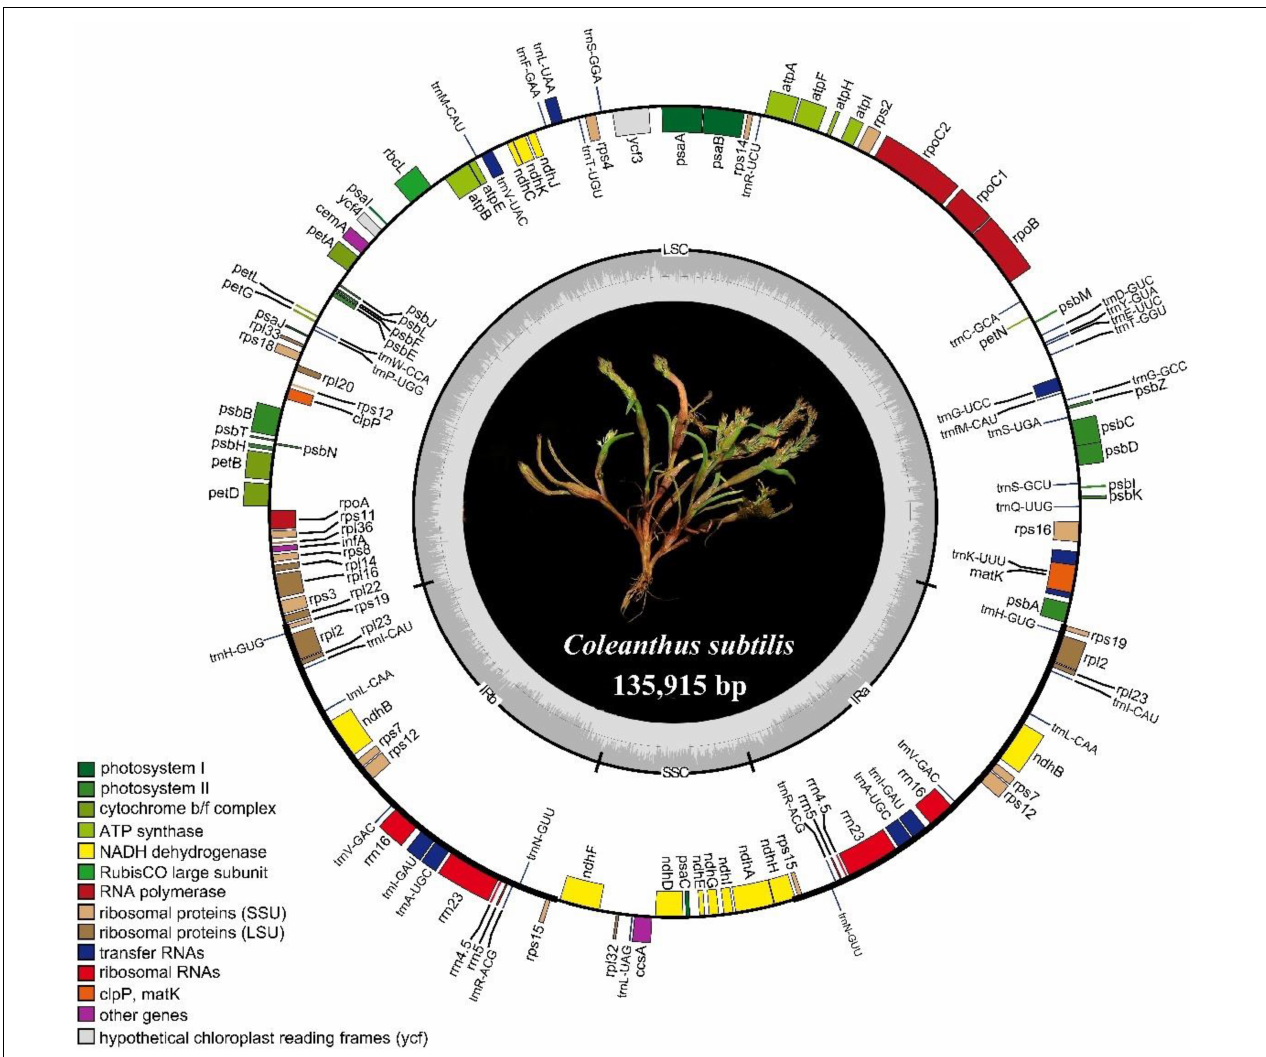
FIGURE 1 | Chloroplast genome map of C. subtilis . The genes located inside the circles are transcribed in a clockwise direction, while those outside the circle are transcribed counterclockwise. Different colored genes represent different functions, as shown in the legend at the bottom left. The inverted boundaries and GC content are drawn in the inner